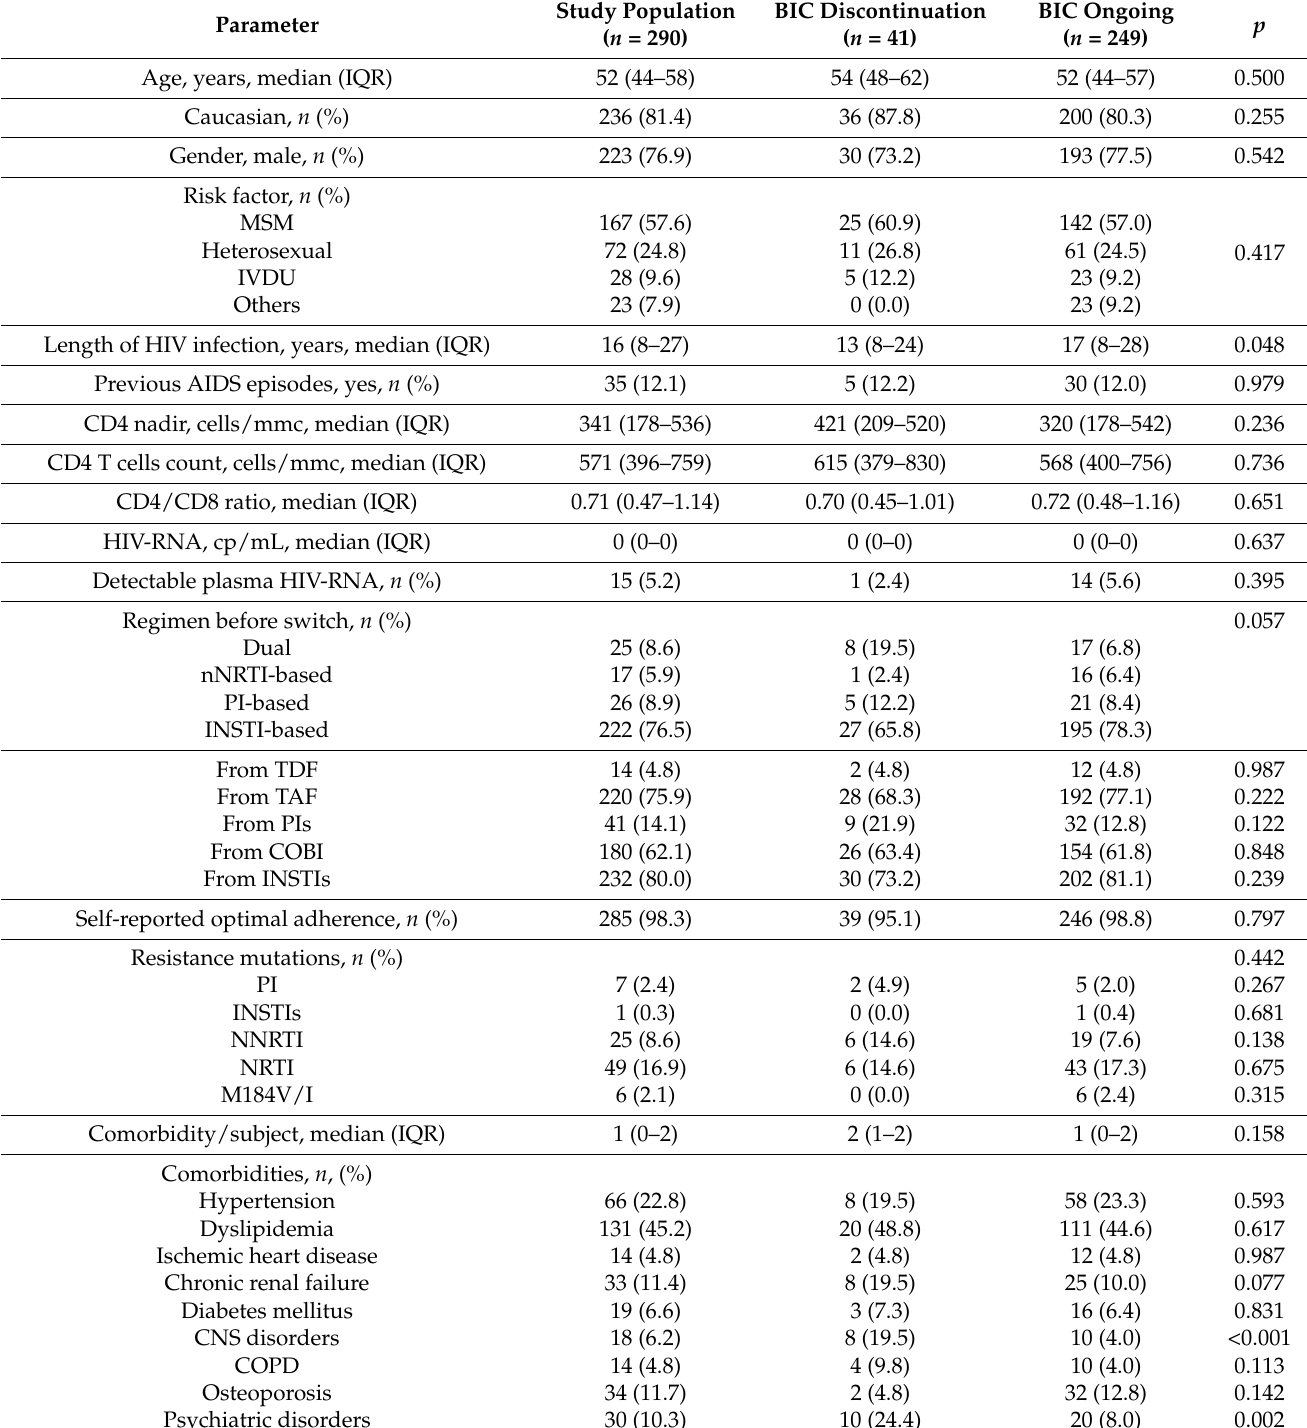
Table 1. Comparison of baseline characteristics between subjects who discontinued BIC/FTC/TAF during the study period and subjects who remained on BIC/FTC/TAF at week